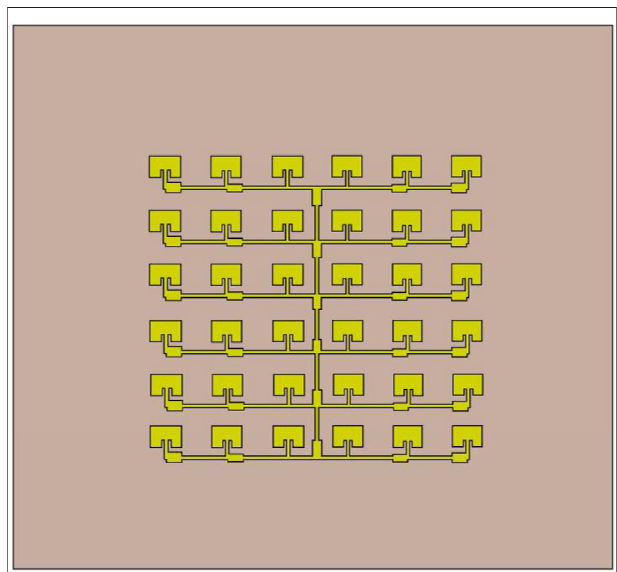
FIGURE6| Diagramoftheradiationsourcecomposedofa6×6metallic patch array with the Chebyshev current strength distribution.